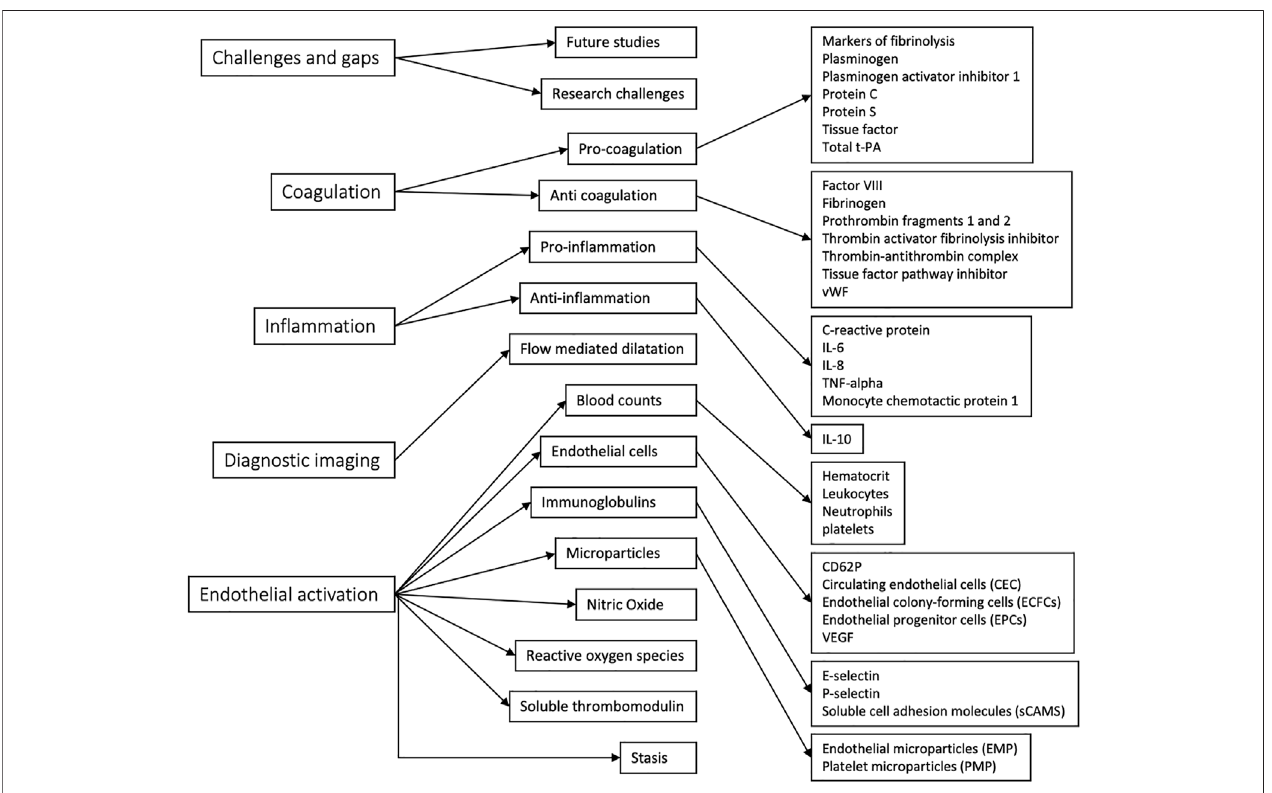
FIGURE 3 | Thematic map, progressing from major themes on the left to minor themes to codes.